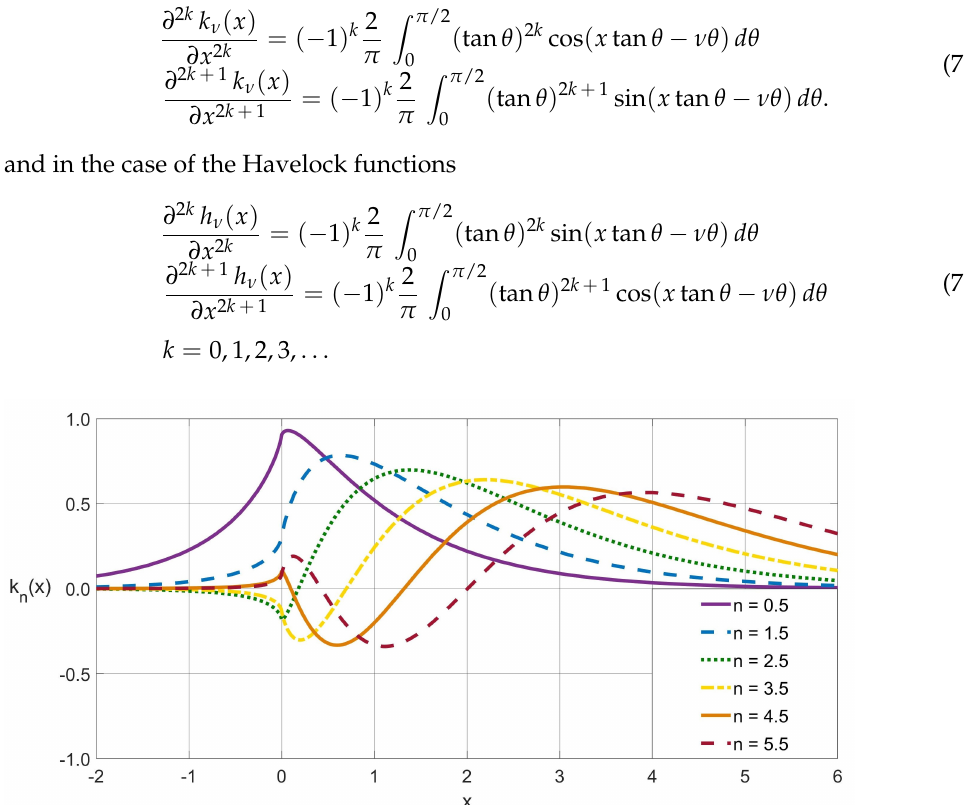
Figure 5. Bateman functions with positive n + 1/2 orders as a function of argument x